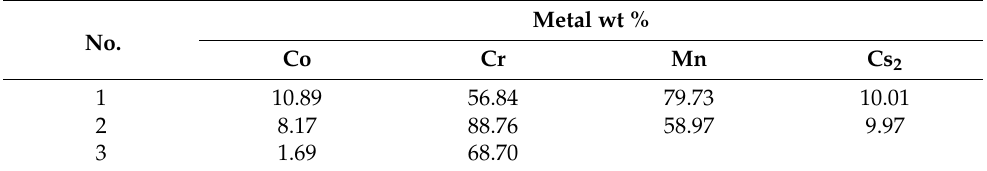
Table 9. Percentage of the surrogate nuclides captured in the